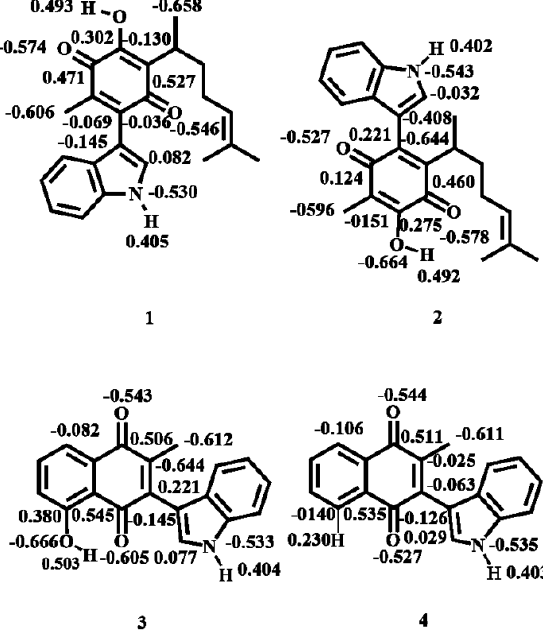
Figure 6. Charge distribution of selected atoms.